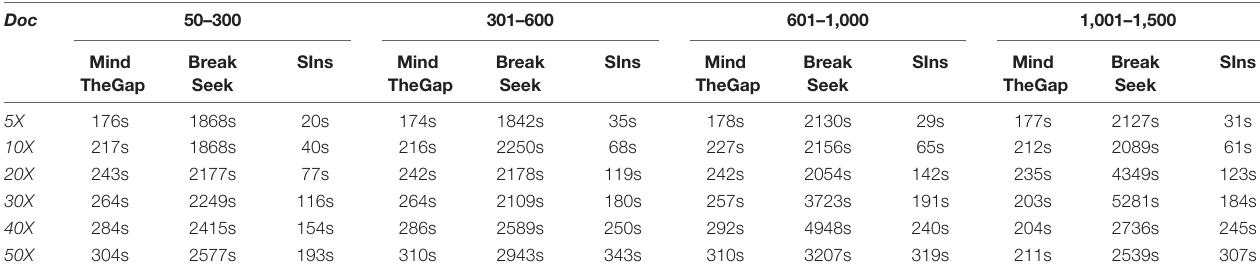
TABLE 4 | Homozygote results obtained with four ranges.